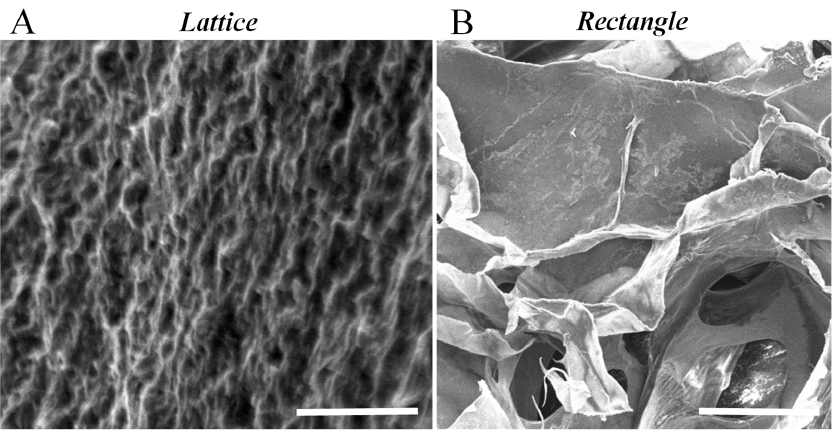
Figure 3. A representative SEM cross-section image of a gelatin lattice structure that was acquired in order to determine the apparent porosity and average pore size ( A ). The cross-sectional SEM image for the rectangular-sheet structure printed using f-gelatin was previously reported ( B ) [7]. The scale bars represent 5 µ m and 500 µ m in A and B respectively.